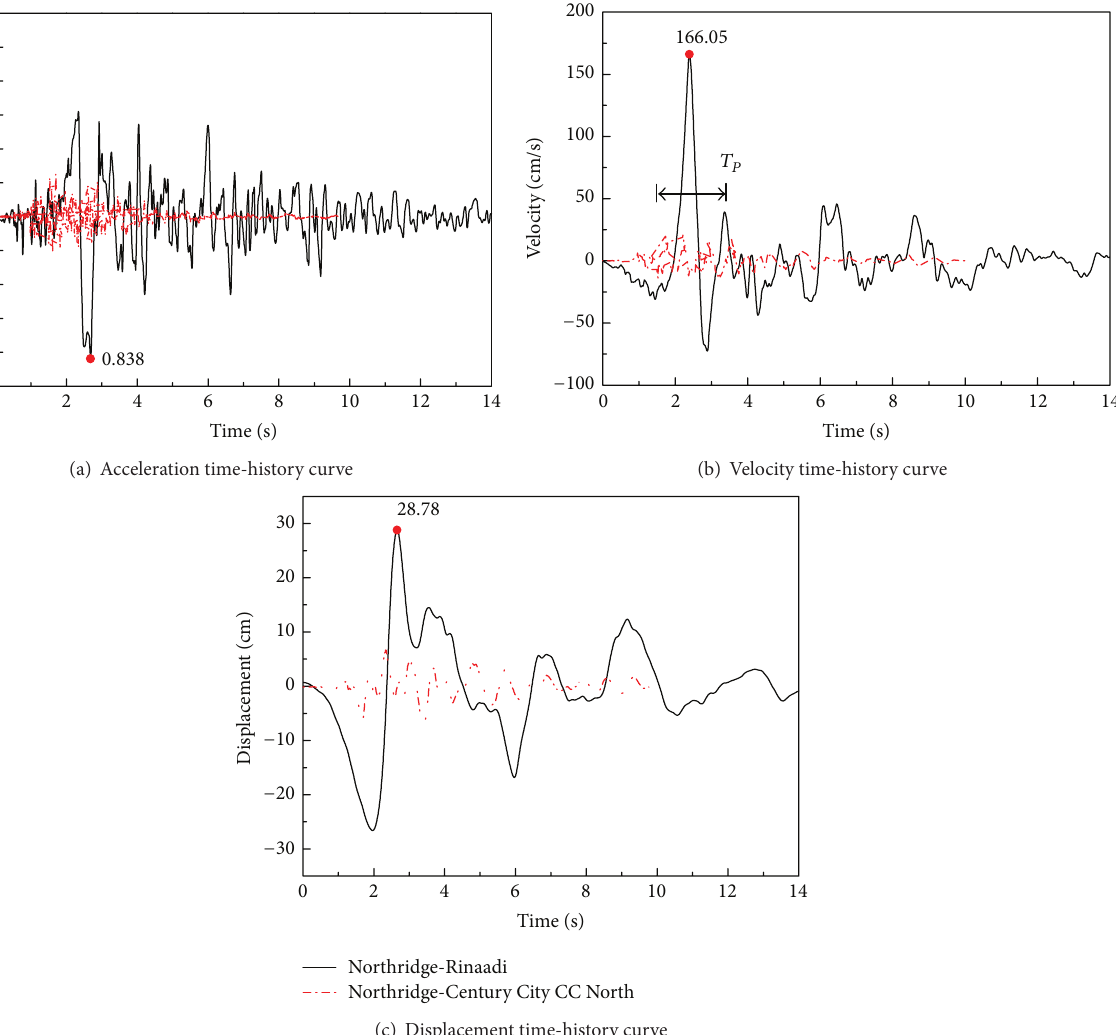
Figure 3: Ground acceleration, velocity, and displacement time histories for record of Northridge Rinaldi and Century City CC North.